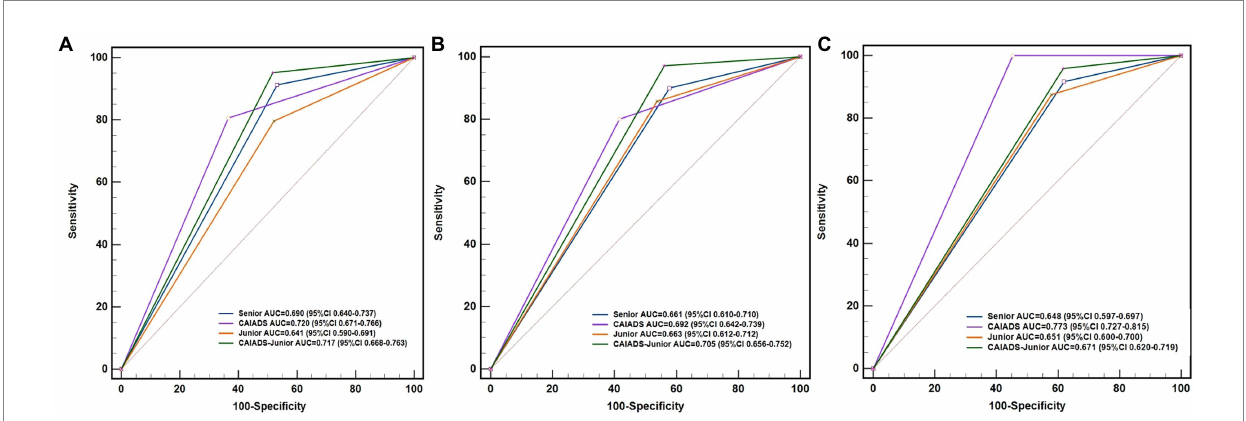
FIGURE 2 ROCs and AUCs of the subspecialists for the different disease endpoints. (A) CIN2+, (B) CIN3+, and (C) cancer. CAIADS, colposcopic artificial intelligence auxiliary diagnostic system; CAIADS-Junior, CAIADS-assisted junior colposcopist; ROC curve, receiver operator characteristic curve; AUC, area under the curve; CIN, cervical intraepithelial neoplasia; CIN2+, CIN grade 2 or worse; CIN3+, CIN grade 3 or worse.